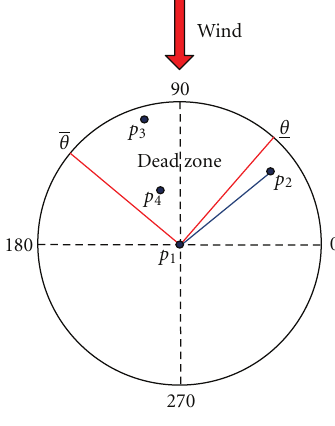
Figure 3: Polar diagram representing the no-sailing